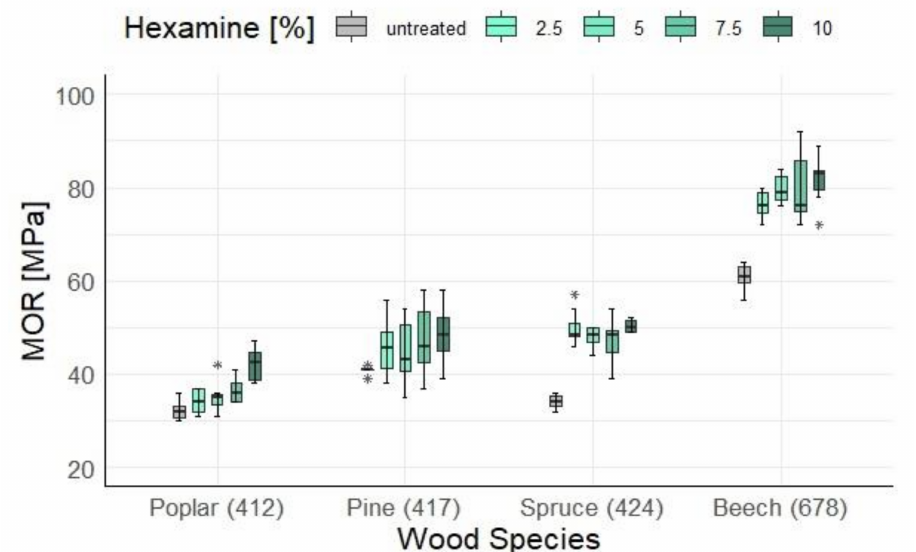
Figure 6. Boxplot chart of modulus of rupture for different wood species at various hexamine amounts. The symbol “ * ” indicates the outliers of the tests performed.